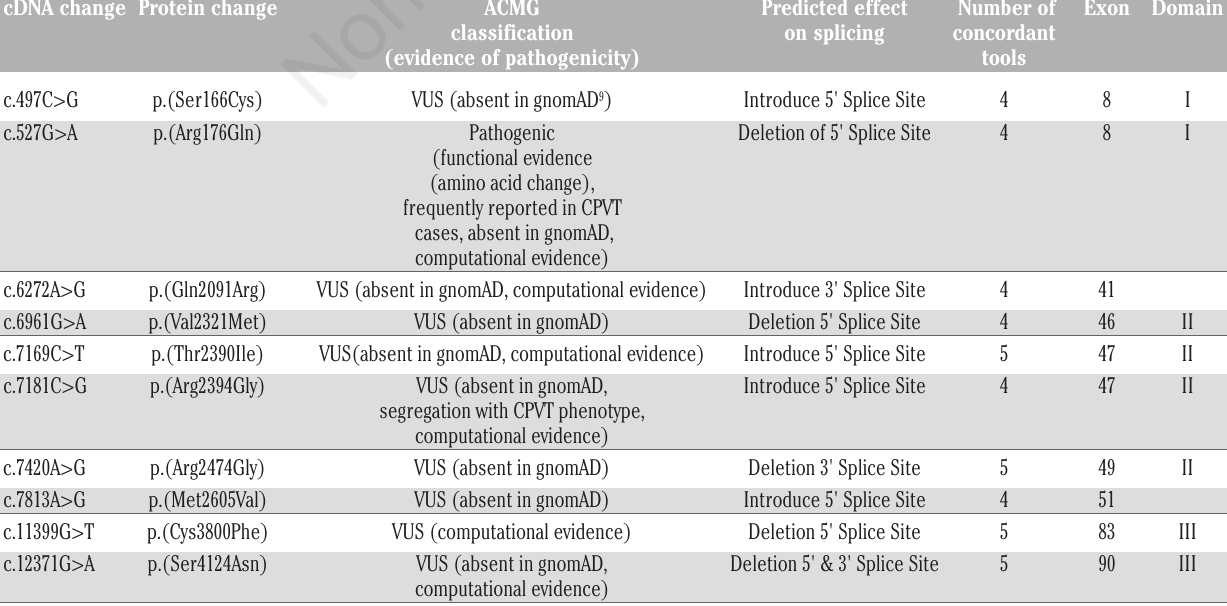
Table 2. CPVT associated RYR2 variants predicted to affect splicing by 4 or 5 of the 5 splice prediction tools. cDNA change Protein change